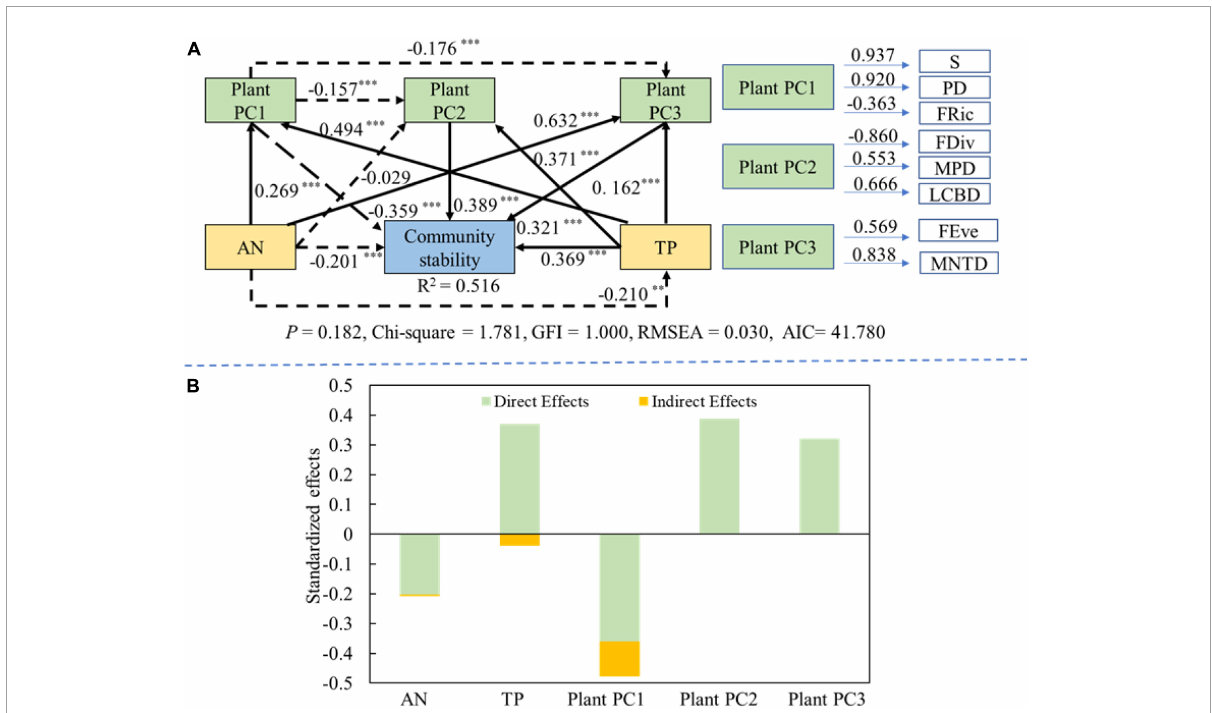
FIGURE7 The effects of plant diversity and soil properties on the community stability. Black solid and black dashed lines indicate the positive and negative effects, respectively. Values on lines denote the standardized effect size. (A) Structural equation model showing the direct and indirect effects of plant diversity and soil factors on community stability. (B) The standardized direct and indirect effects about structural equation model. ** P < 0.01; *** P <